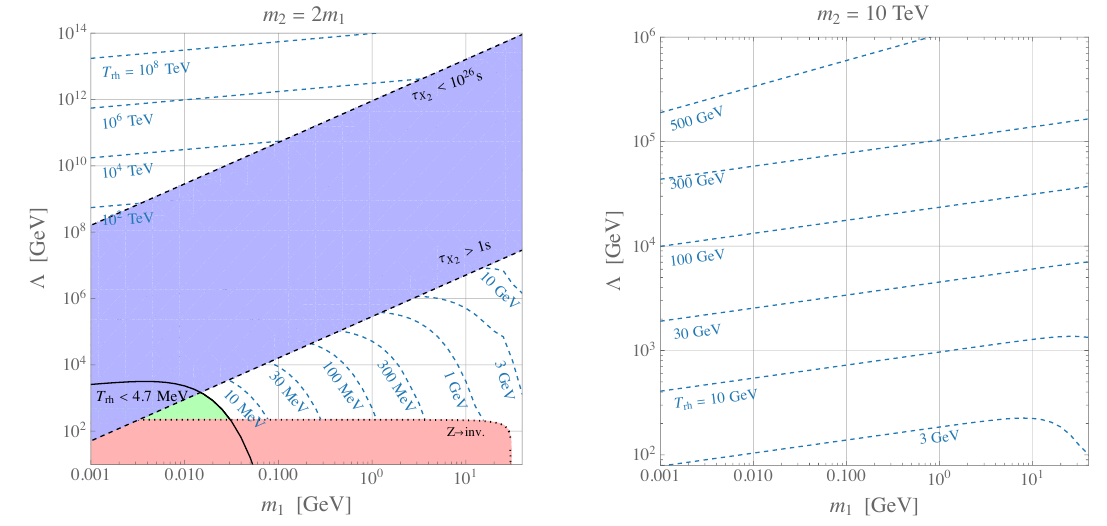
Figure 2 . Reheat temperature to reproduce the observed dark matter abundance. The curves have been evaluated for C = 0 and C = 1 / Λ 2 . The red shaded region is excluded by the BX 2 e BX 2 invisible width of the Z , the blue shaded region by lifetime constraints on X 2 , and the green shaded region by the limit T rh < 4 . 7 MeV from the CMB and BBN